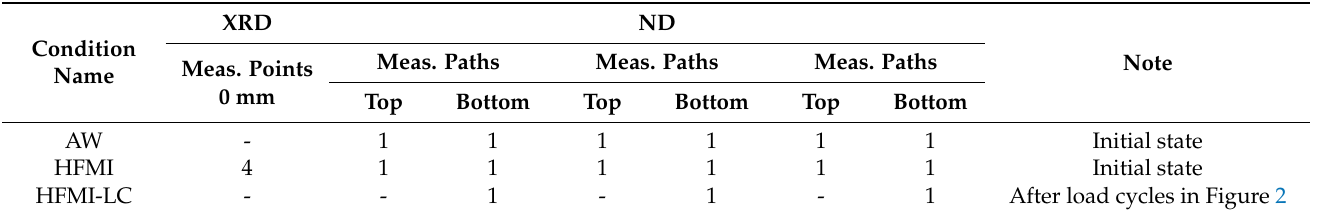
Table 2. Test matrix of residual stress measurements.